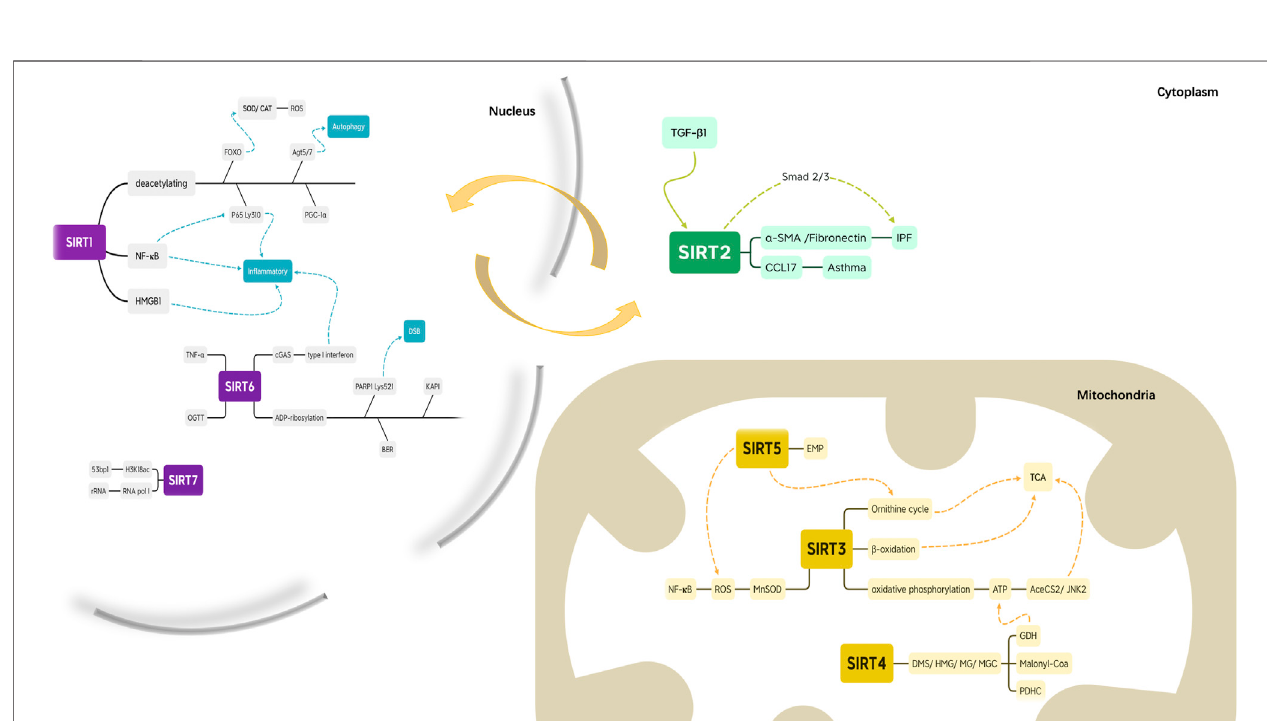
FIGURE 3 | The relationship between cellular locations and enzymatic